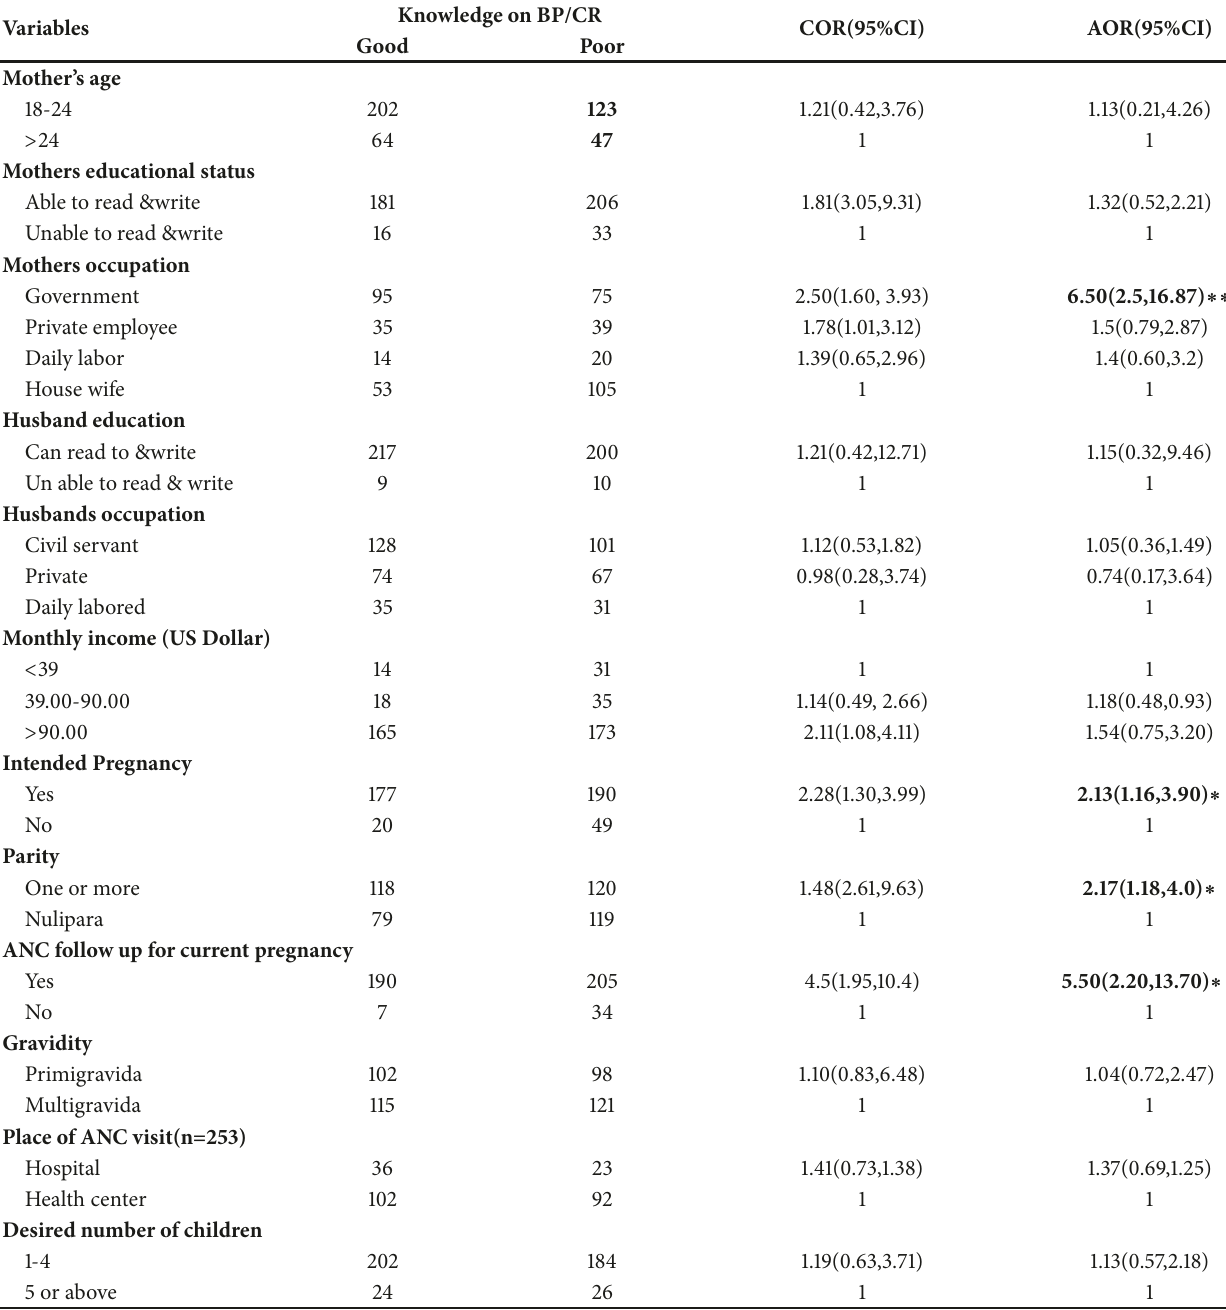
Table 4: Bivariate and Multivariable logistic regression analysis for factors associated with knowledge on BP/CR among pregnant women at Debre Markos town, Northwest Ethiopia,